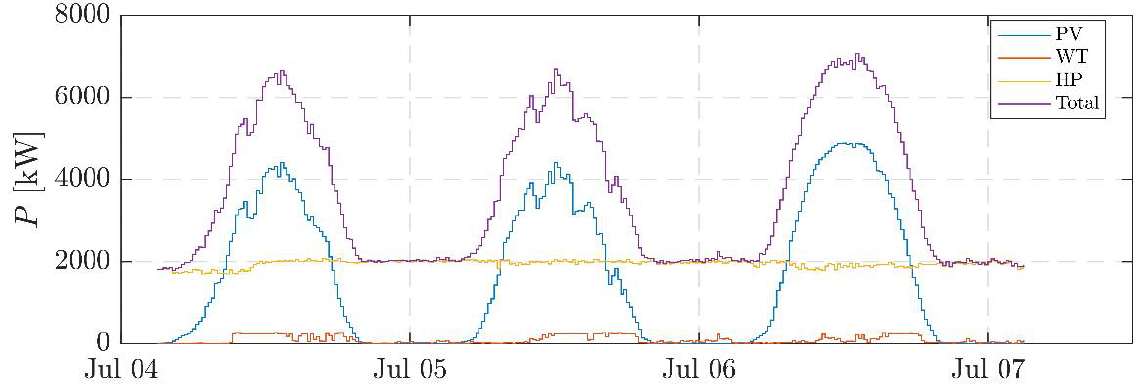
Figure 6. Example of EVU production profile.